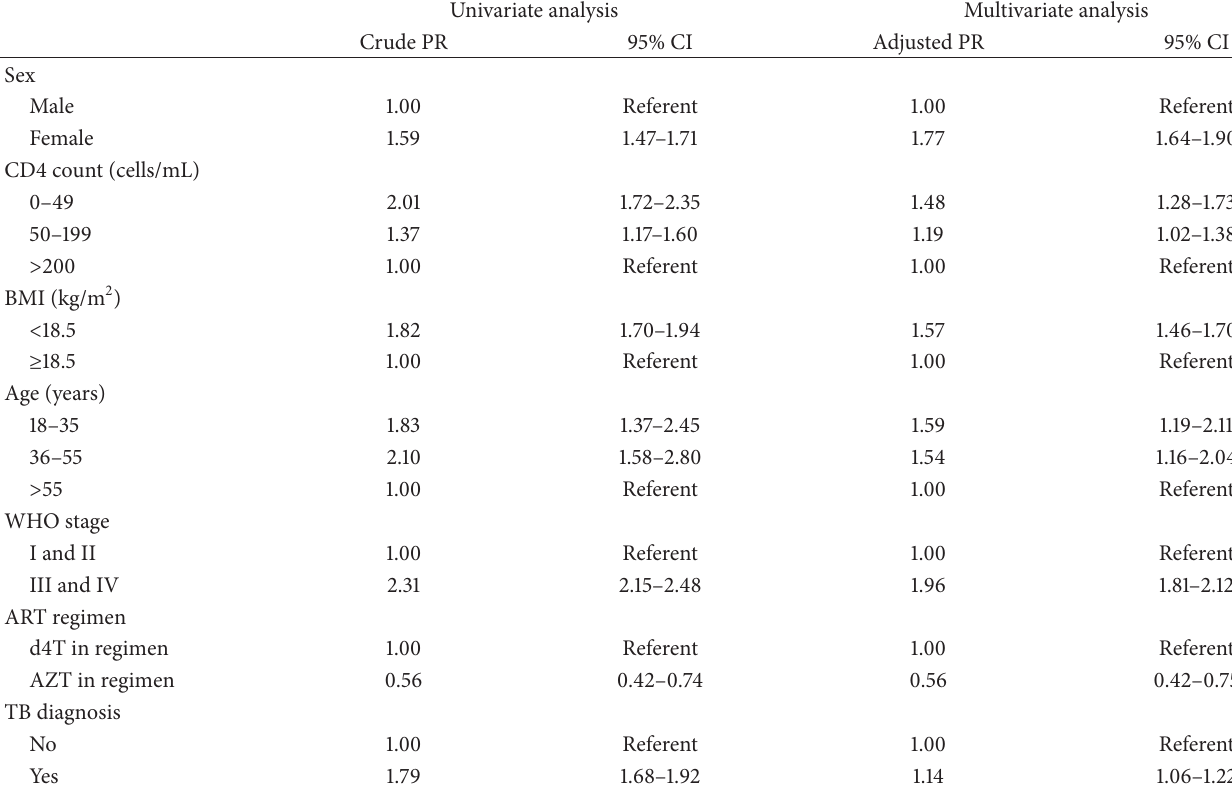
Table 2: Association of baseline characteristics with prevalent anemia among 10,259 patients initiating first-line ART at the Themba Lethu Clinic in Johannesburg, South